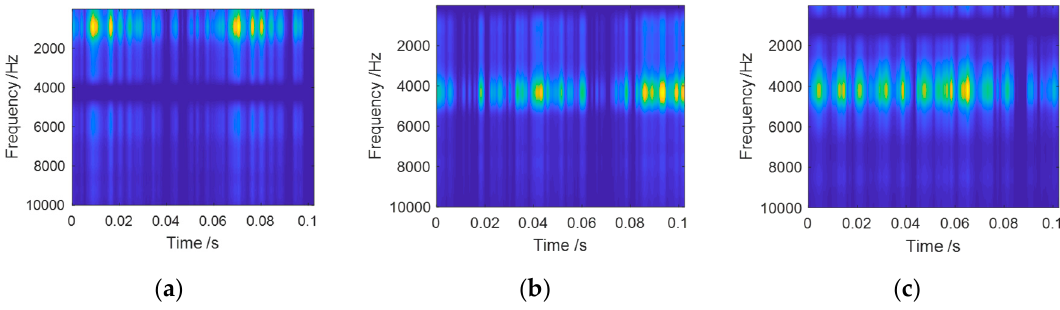
Figure 7. Reconstructed time-frequency distributions based on the vector product: ( a ) Reconstructed time-frequency distribution (TFD) 1; ( b ) reconstructed TFD 2; ( c ) reconstructed TFD 3.